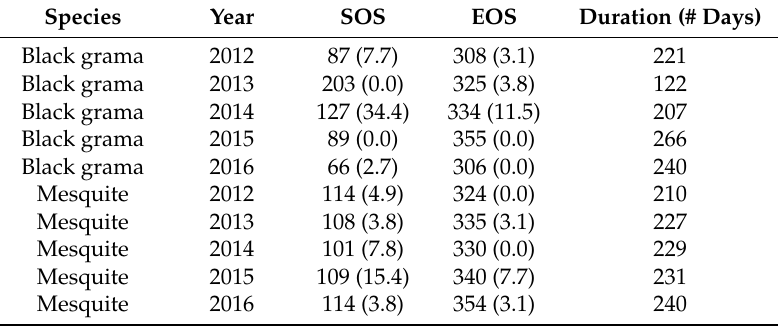
Table 1. Field-observed dates for growing season start (SOS; unfolded leaves) and growing season end (EOS; green leaves =0) for black grama ( Bouteloua eriopoda ) and mesquite ( Prosopis glandulosa ) focal plants. Dates are reported as day of year. Observations were collected every seven days using standardized protocols [42]. Values are the mean date for five focal plants with SD in